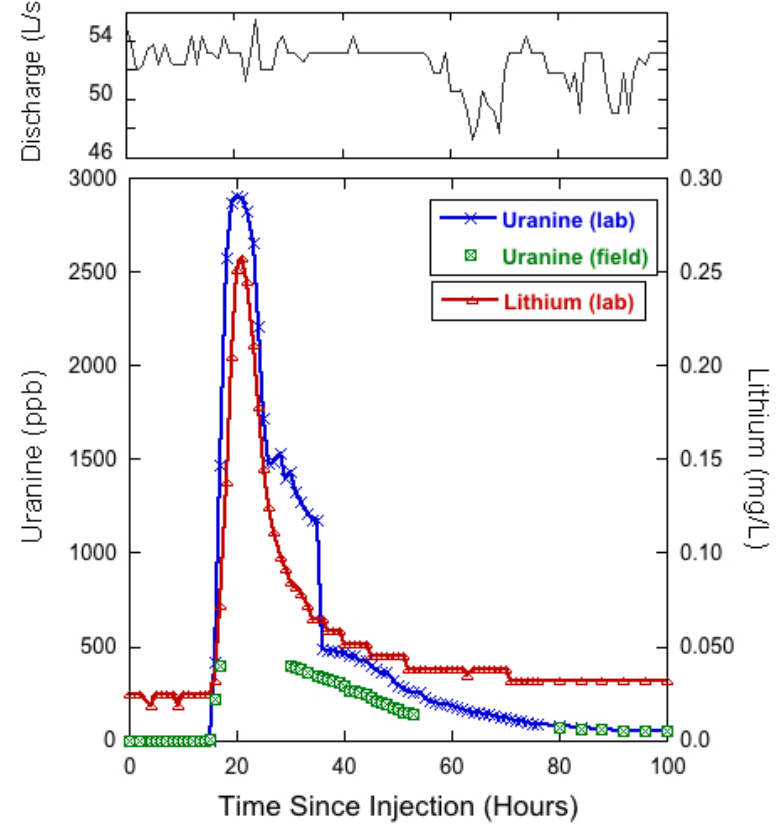
Figure 8. Time series of hourly discharge ( top ) and tracer break through curves ( bottom ) for lithium and uranine at the St. Louis Tunnel portal. Time 0 represents 12:00 on 4